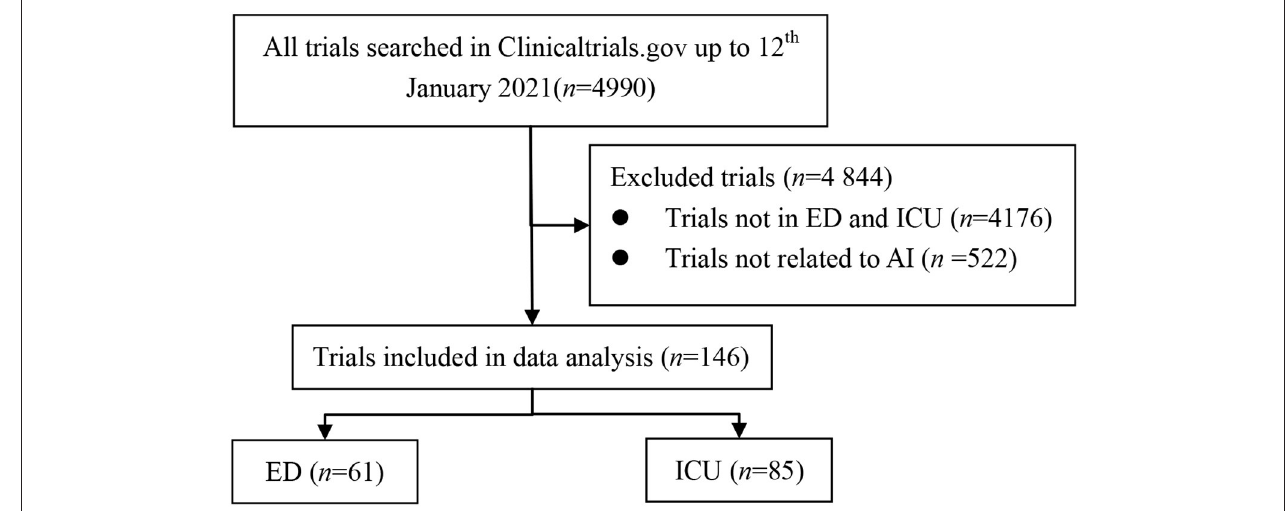
FIGURE 1 | Flowchart of recruited trials registered in ClinicalTrials.gov up to 12th January